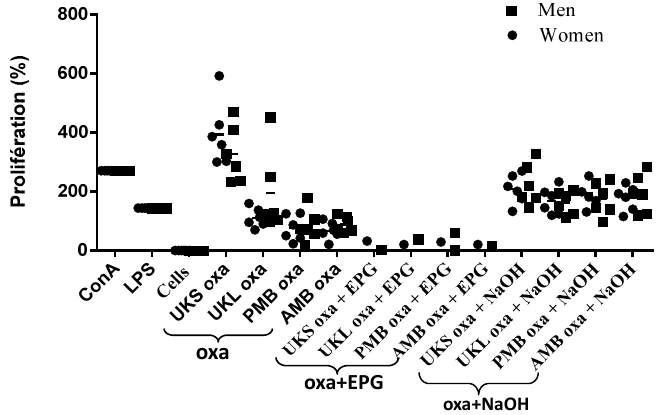
Figure 5. Proliferation of PMBCs from 12 volunteers stimulated by polysaccharide extracts: pectin (oxa), oxalate saponified (oxa + NaOH) or digested with EPG (oxa + EPG) compared with concanavalin A (ConA), lipopolysaccharide (LPS) and unstimulated cells; mean ± SD.